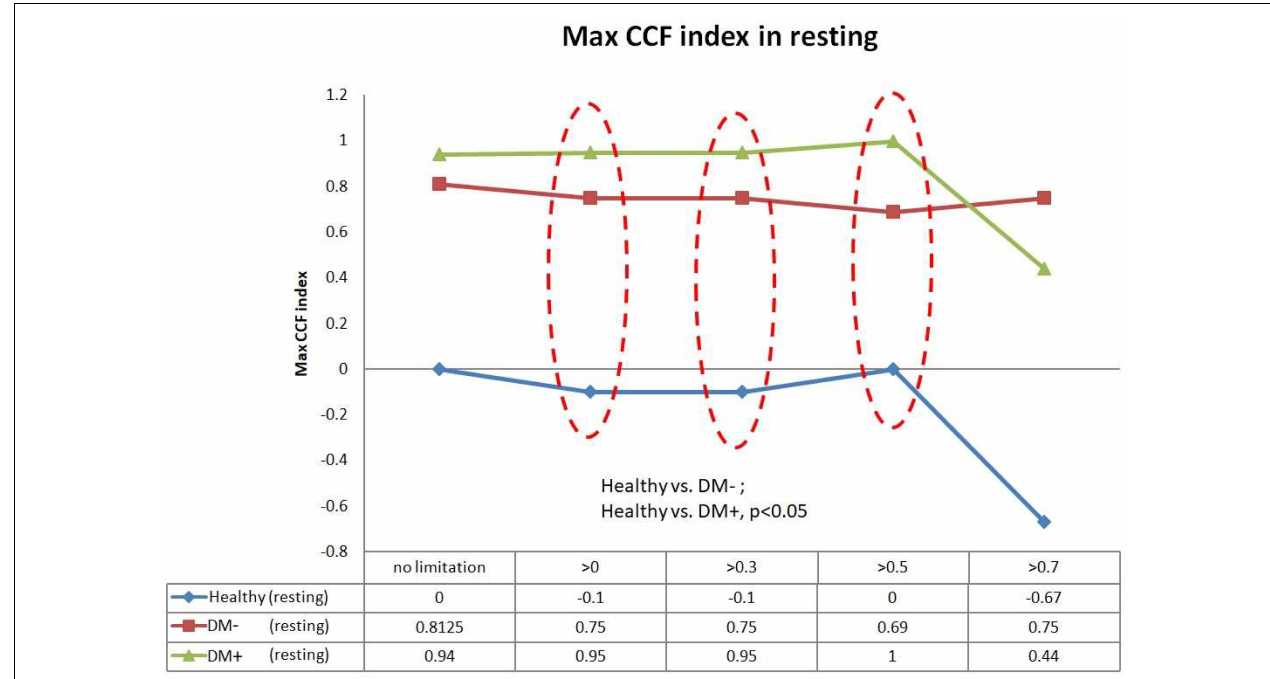
FIGURE 9 | The plot of the maximum CCF index with different thresholds by ACCF results in the supine position. ACCF phase analysis during resting supine. Filtered maximum CCF index in healthy (blue), diabetes mellitus (DM–, red), and DM with autonomic neuropathy (DM+, green). When the threshold setting was greater than 0, 0.3, and 0.5, the filtered maximum CCF index could significantly separate the healthy group from the DM– and DM+ group ( p < 0.05). It also indicates that the phase between HR and BP was prolonged in DM.